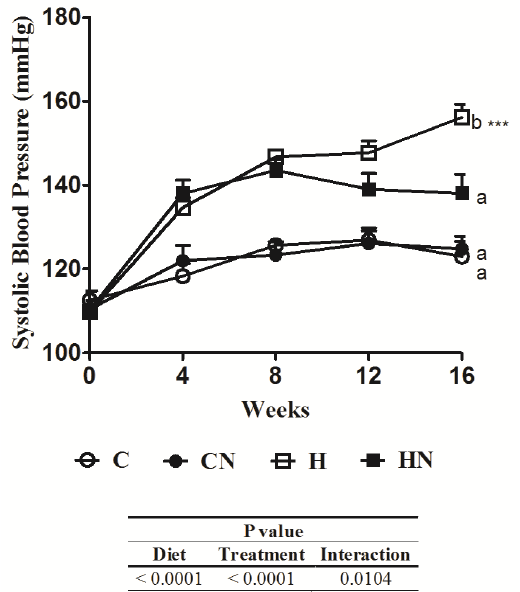
Figure 1. Effect of naringin on systolic blood pressure. Time course of tail cuff systolic blood pressure of Wistar rats given C, CN, H and HN ( n = 9 in each group). Means without a common letter are significantly different at p < 0.05.